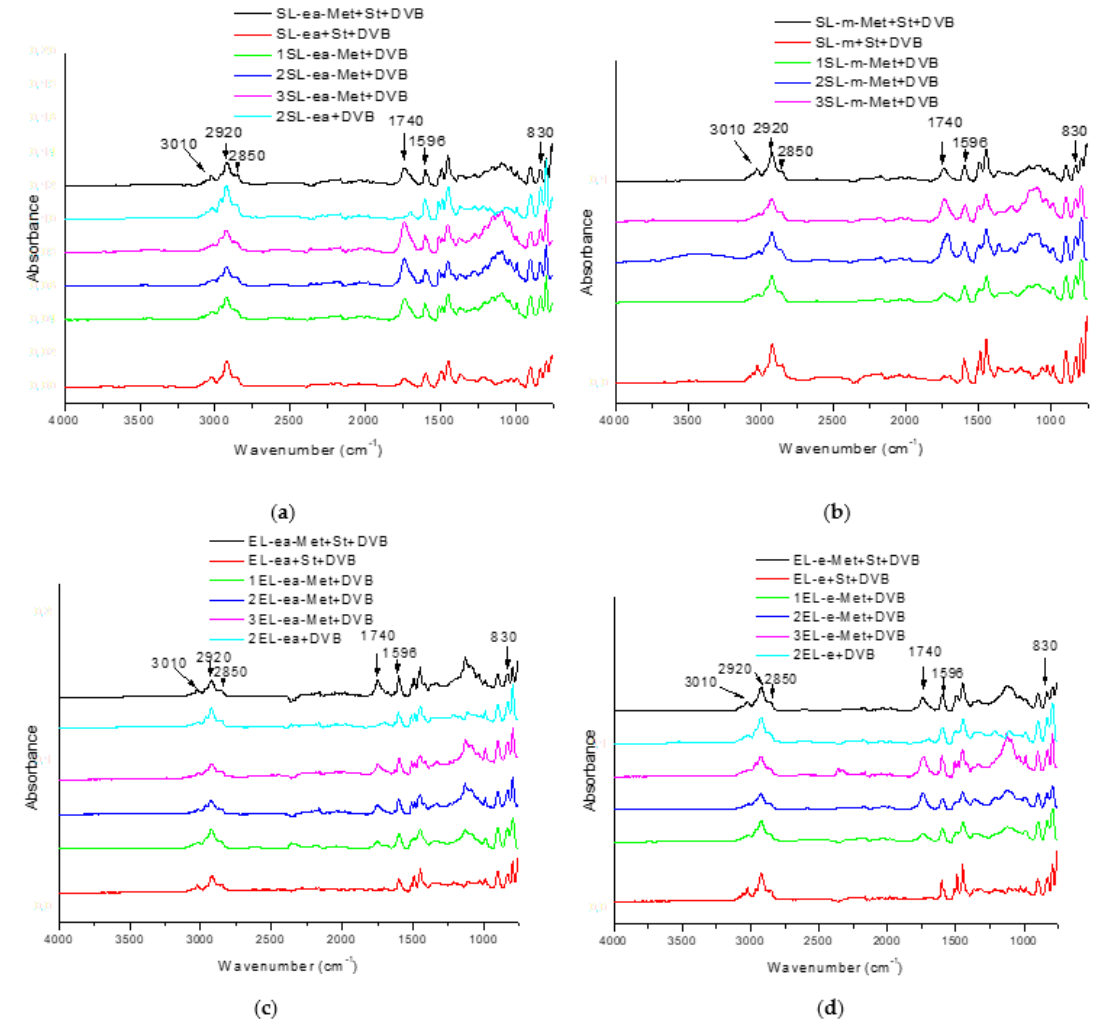
/ FTIR spectra of polymers with ( a ) SL-ea, ( b ) SL-m, ( c ) EL-ea, and ( d ) Figure 2. ATR/FTIR spectra of polymers with ( a ) SL-ea, ( b ) SL-m, ( c ) EL-ea, and ( d ) EL-e. Figure 2. ATR